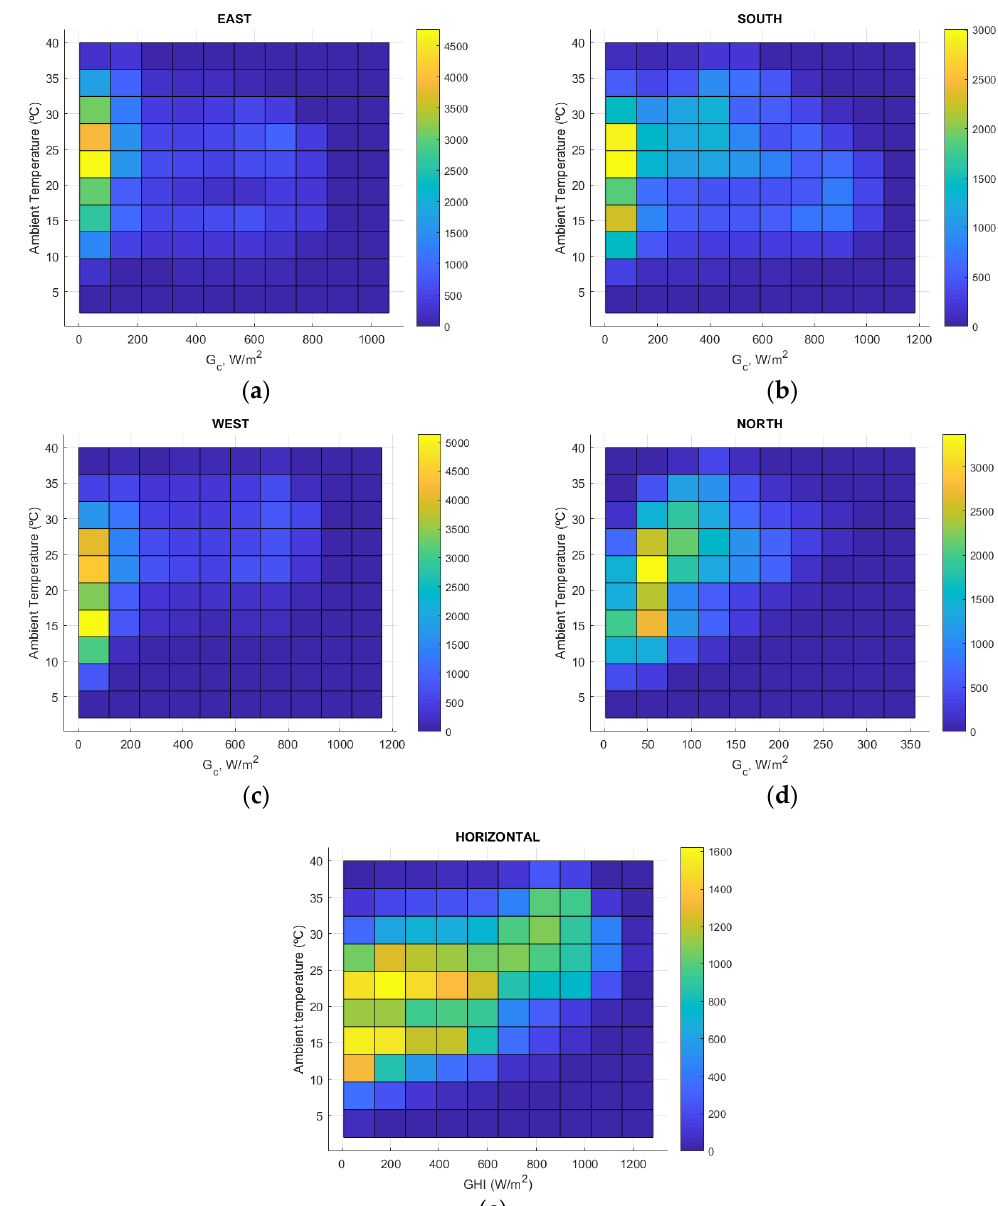
Figure 10. Combination of in-plane irradiance calculated by Muneer’s method from horizontal irradiance records and ambient temperature collected at the weather station for ( a ) vertical east-facing surface, ( b ) vertical south-facing surface, ( c ) vertical west-facing surface, ( d ) vertical north-facing surface and ( e ) horizontal surface. Frequency of observations are plotted on the right bar where the colour scale indicates the number of observations.